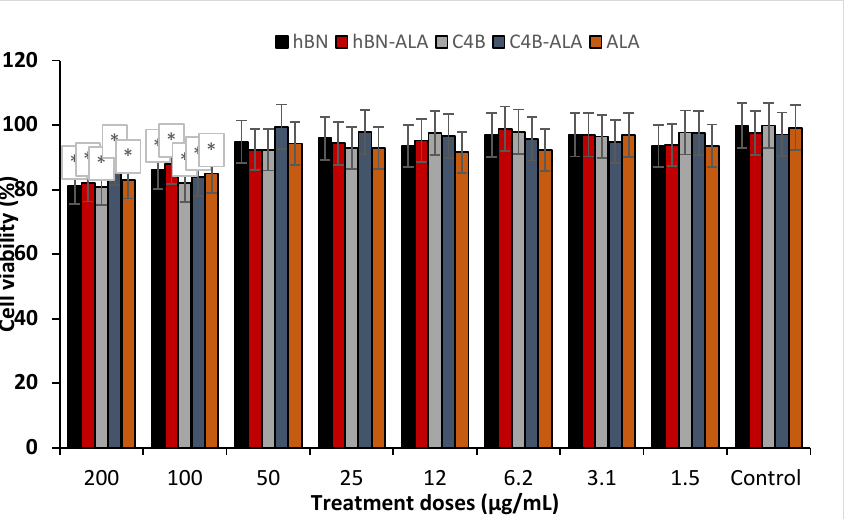
Figure 4. MTT assay in HDF cell cultures for hBN, hBN ‐ ALA, B 4 C, B 4 C ‐ ALA, and ALA at 24 h. Symbol (*) represents statistically significant difference ( p ≤ 0.05) compared to the negative control.